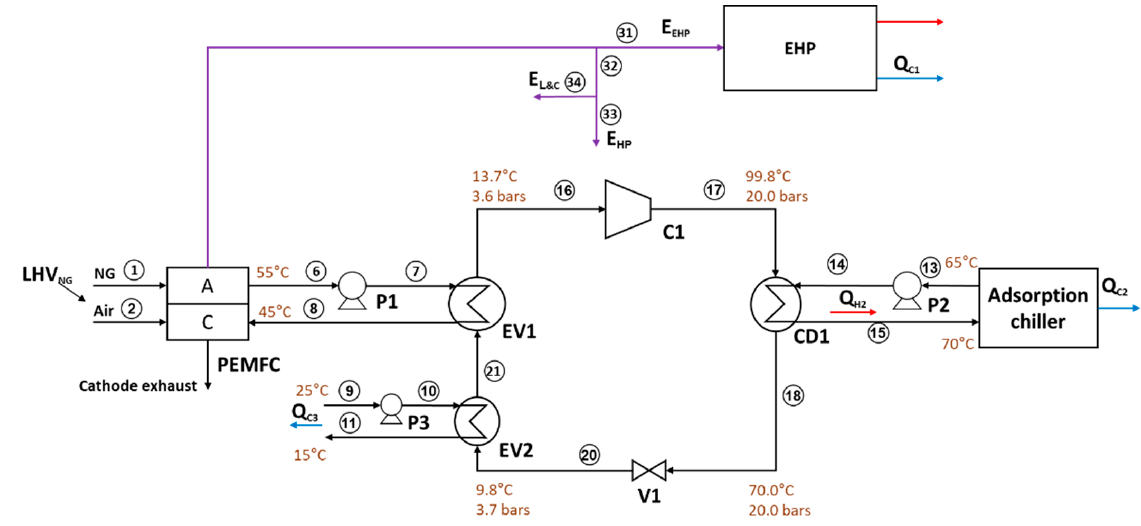
Figure 2. Proposed layout with a simple heat pump (case A).